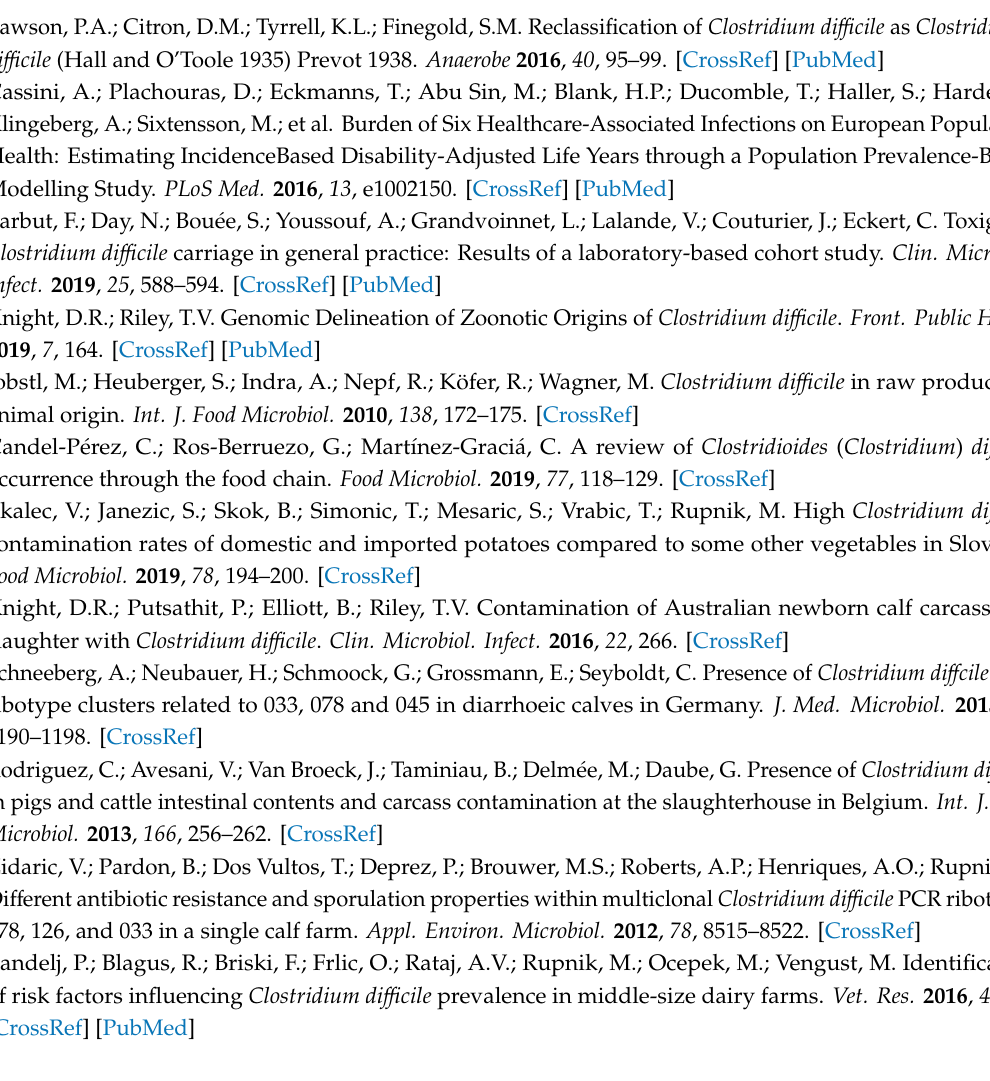
Table S1: Overview of farms included in the study; Table S2: Primers used in the study; Table S3: Overview of characterisation of C. di ffi cile isolates in the